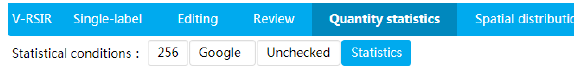
Figure 8. Interface of image statistics